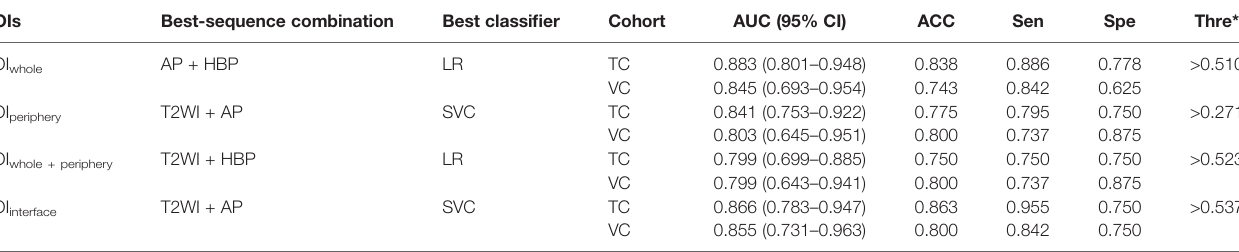
TABLE 4 | Predictive ef fi cacy of multi-sequence radiomics models based on different VOIs. VOIs